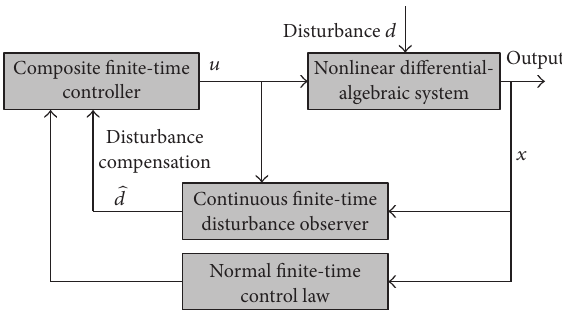
Figure 1: The block diagram of the proposed composite control